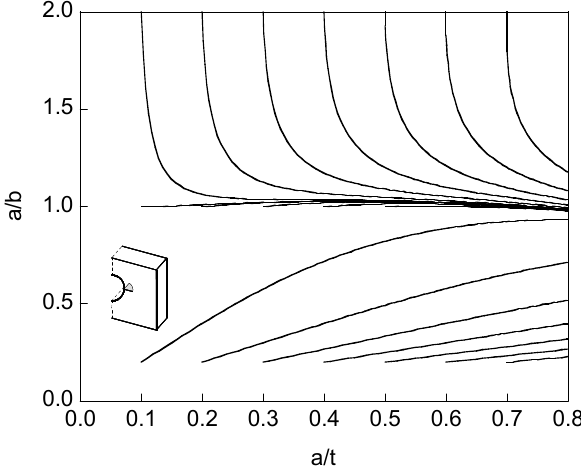
Figure 4. Crack aspect ratio evolution during fatigue propagation in air for cracks emanating from a hole with r = 2 t .